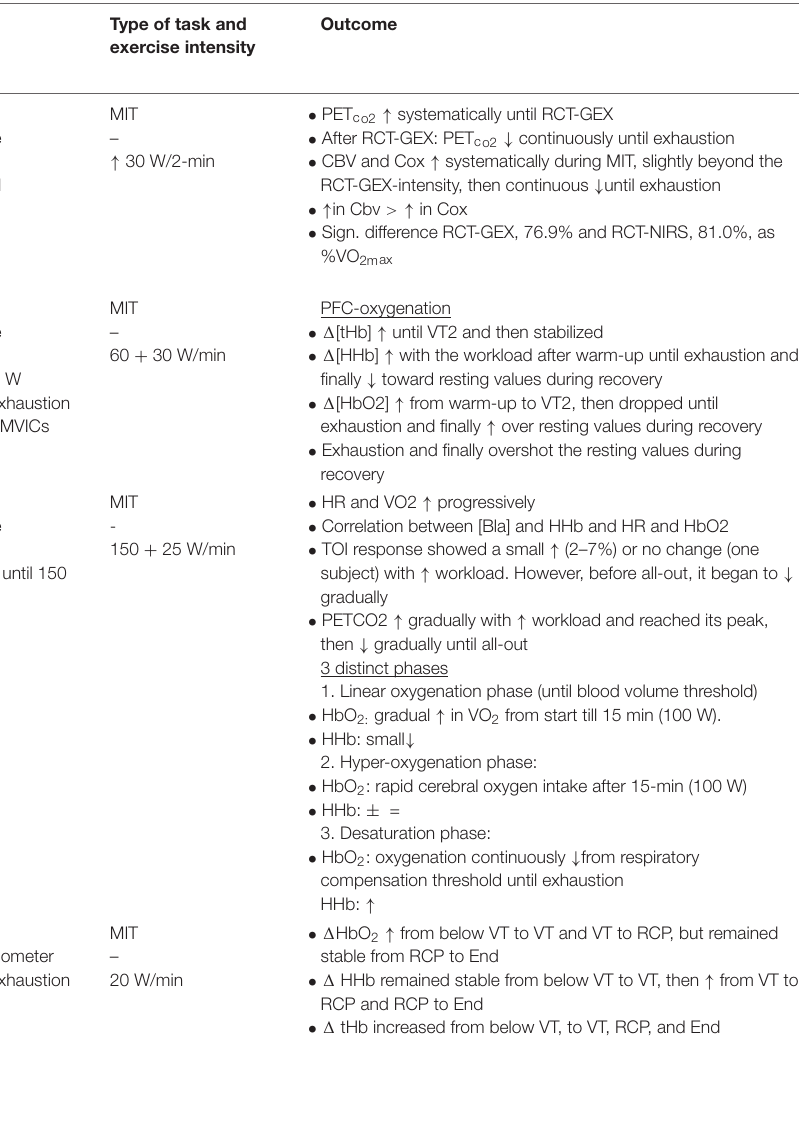
TABLE 5B | Overview of the results within “maximal incremental exercise (MIT)”.